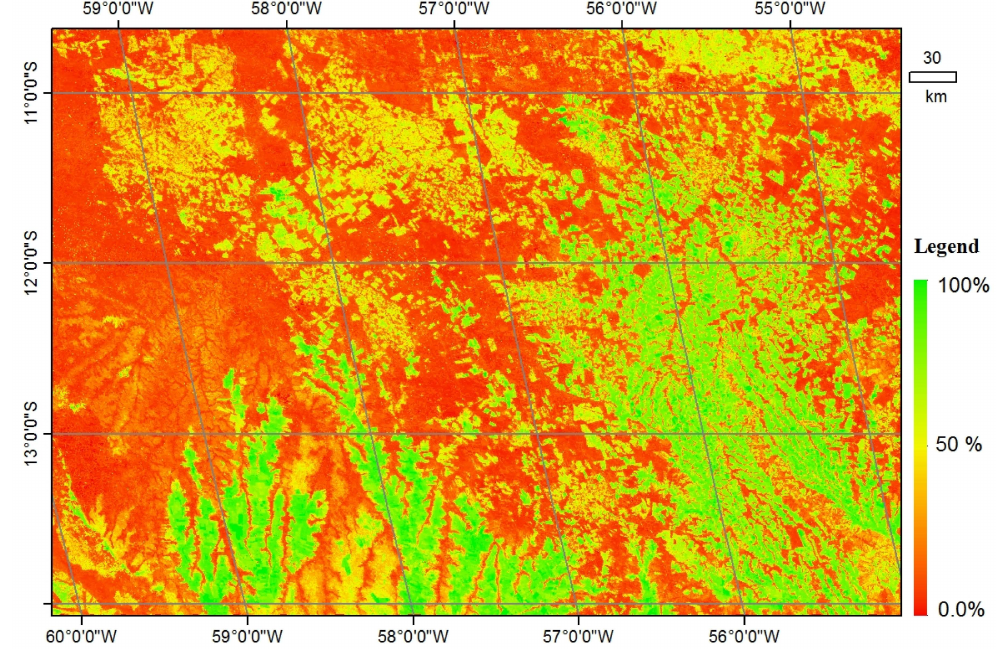
Figure 6. Fractional cropland distribution which is developed using the regression model based on MODIS EVI data in Mato Grosso,